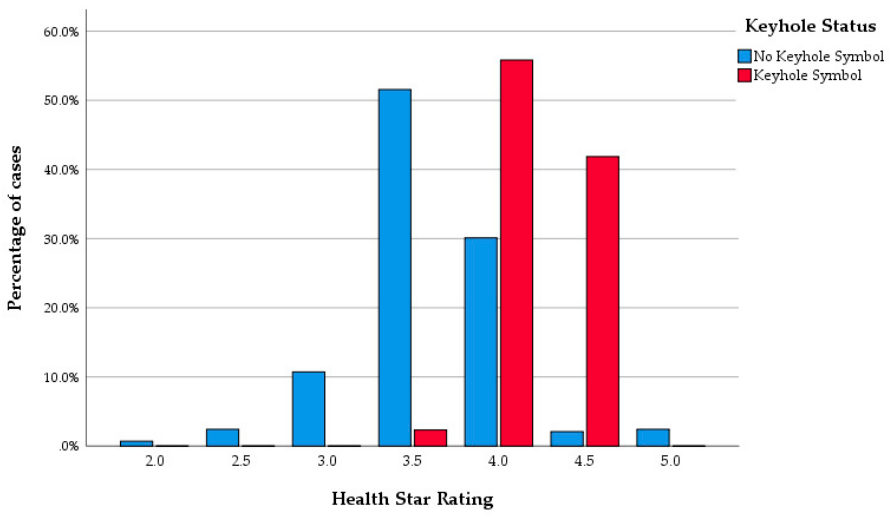
Figure 1. Health Star Rating of products according to Keyhole status.